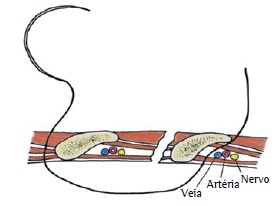
Ilustração de sutura subperiostal.